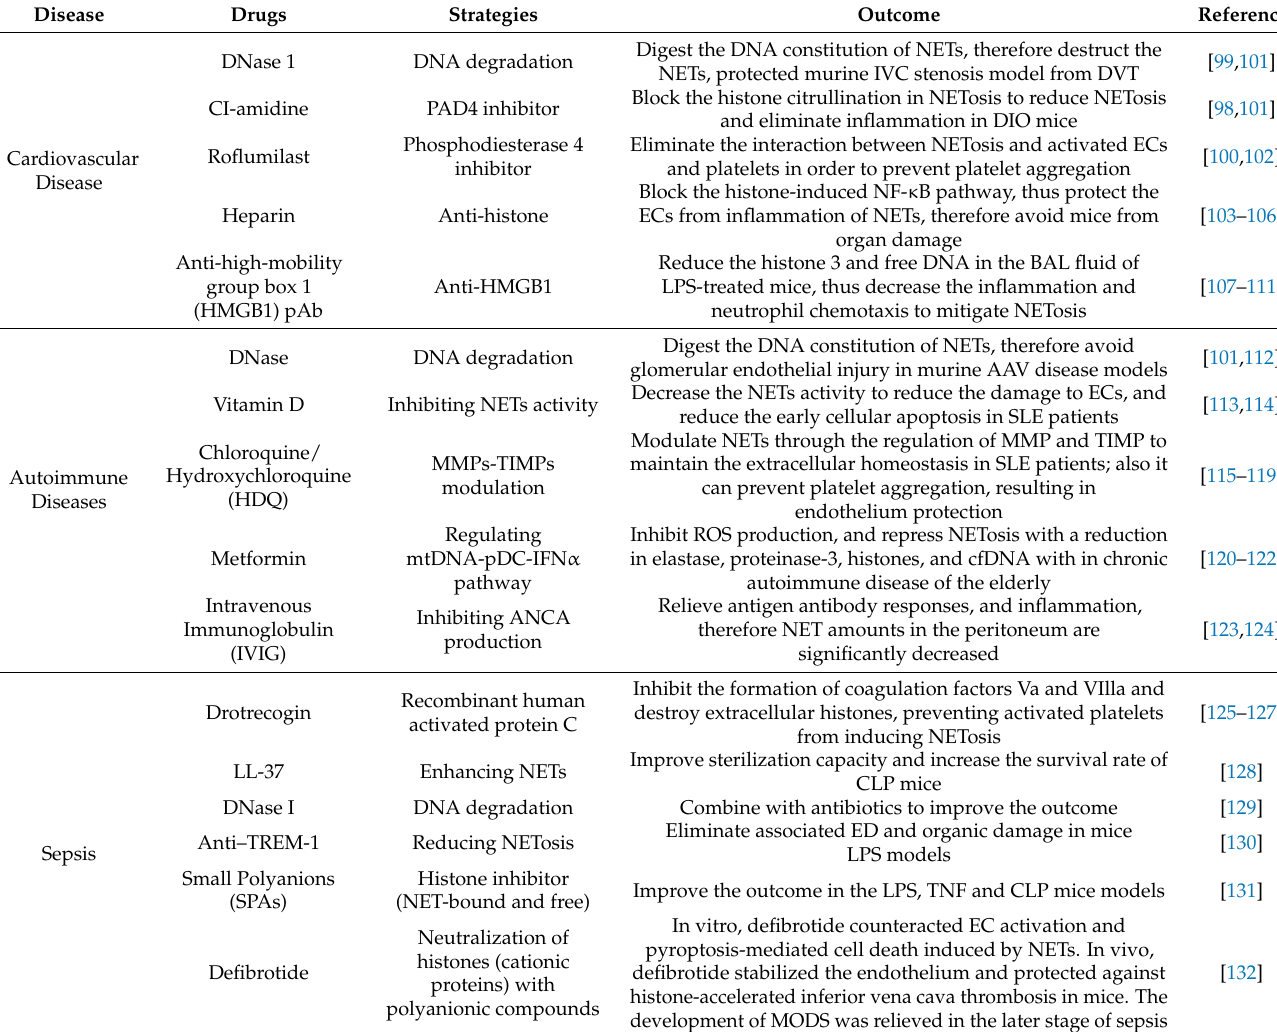
Table 1. Summary of therapeutic strategy targeting